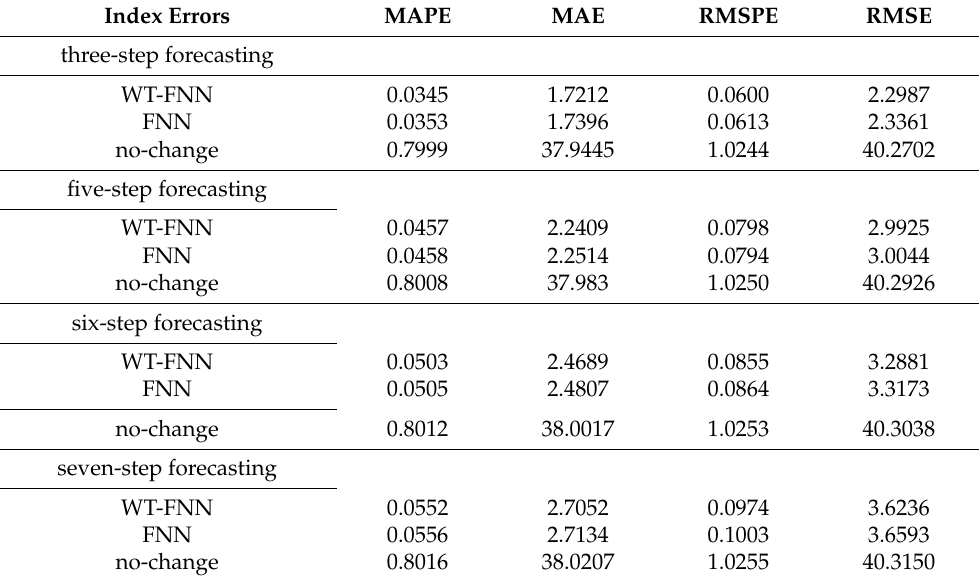
Table 3. Comparisons of predictions from different forecasting models for the different